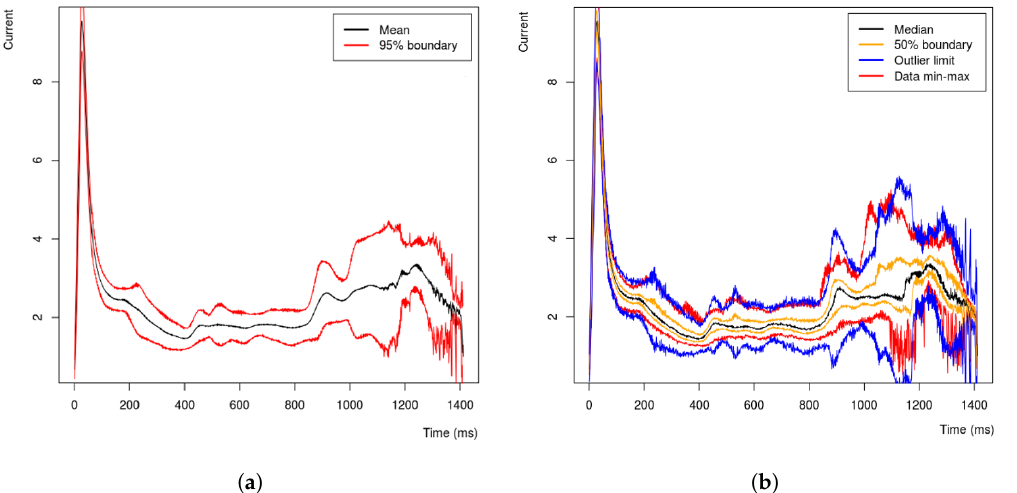
Figure 3. Statistical exploration: ( a ) Initial statistical model, ( b ) identification of bands for quartiles and